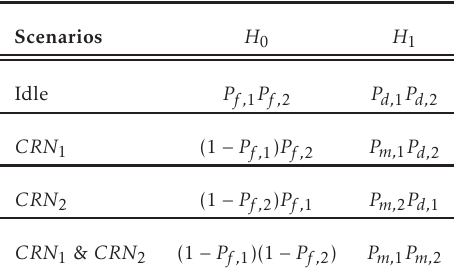
Table 1. Possible transmission scenarios